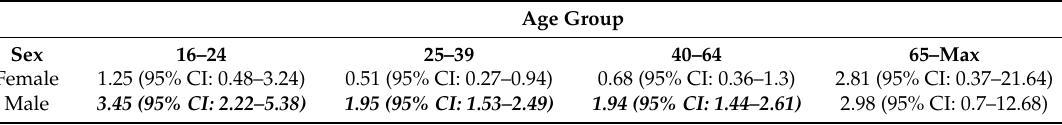
Table 3. Sex and Age group stratified odds ratios * (95% CI) for the outcome seen by psychiatrist for the comparison NA vs. Swiss ( n = 116,859) (significant associations in italic and